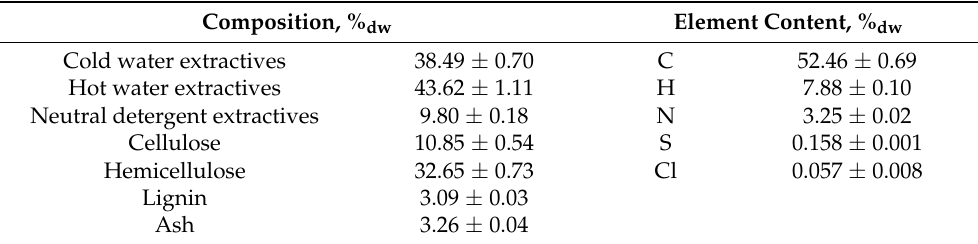
Table 1. Chemical composition of applied brewers’ spent